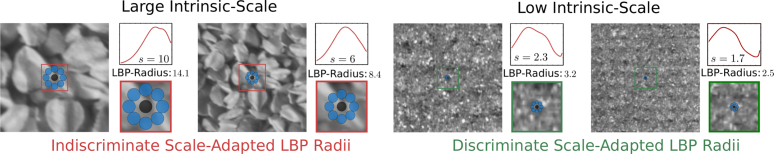
Impact of intrinsic-scales on scale-adapted LBP-radii.